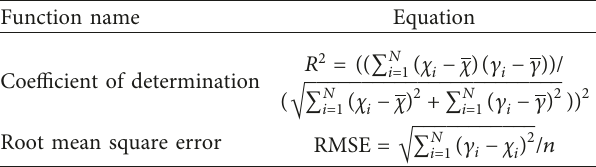
Table 1: Cross-validation